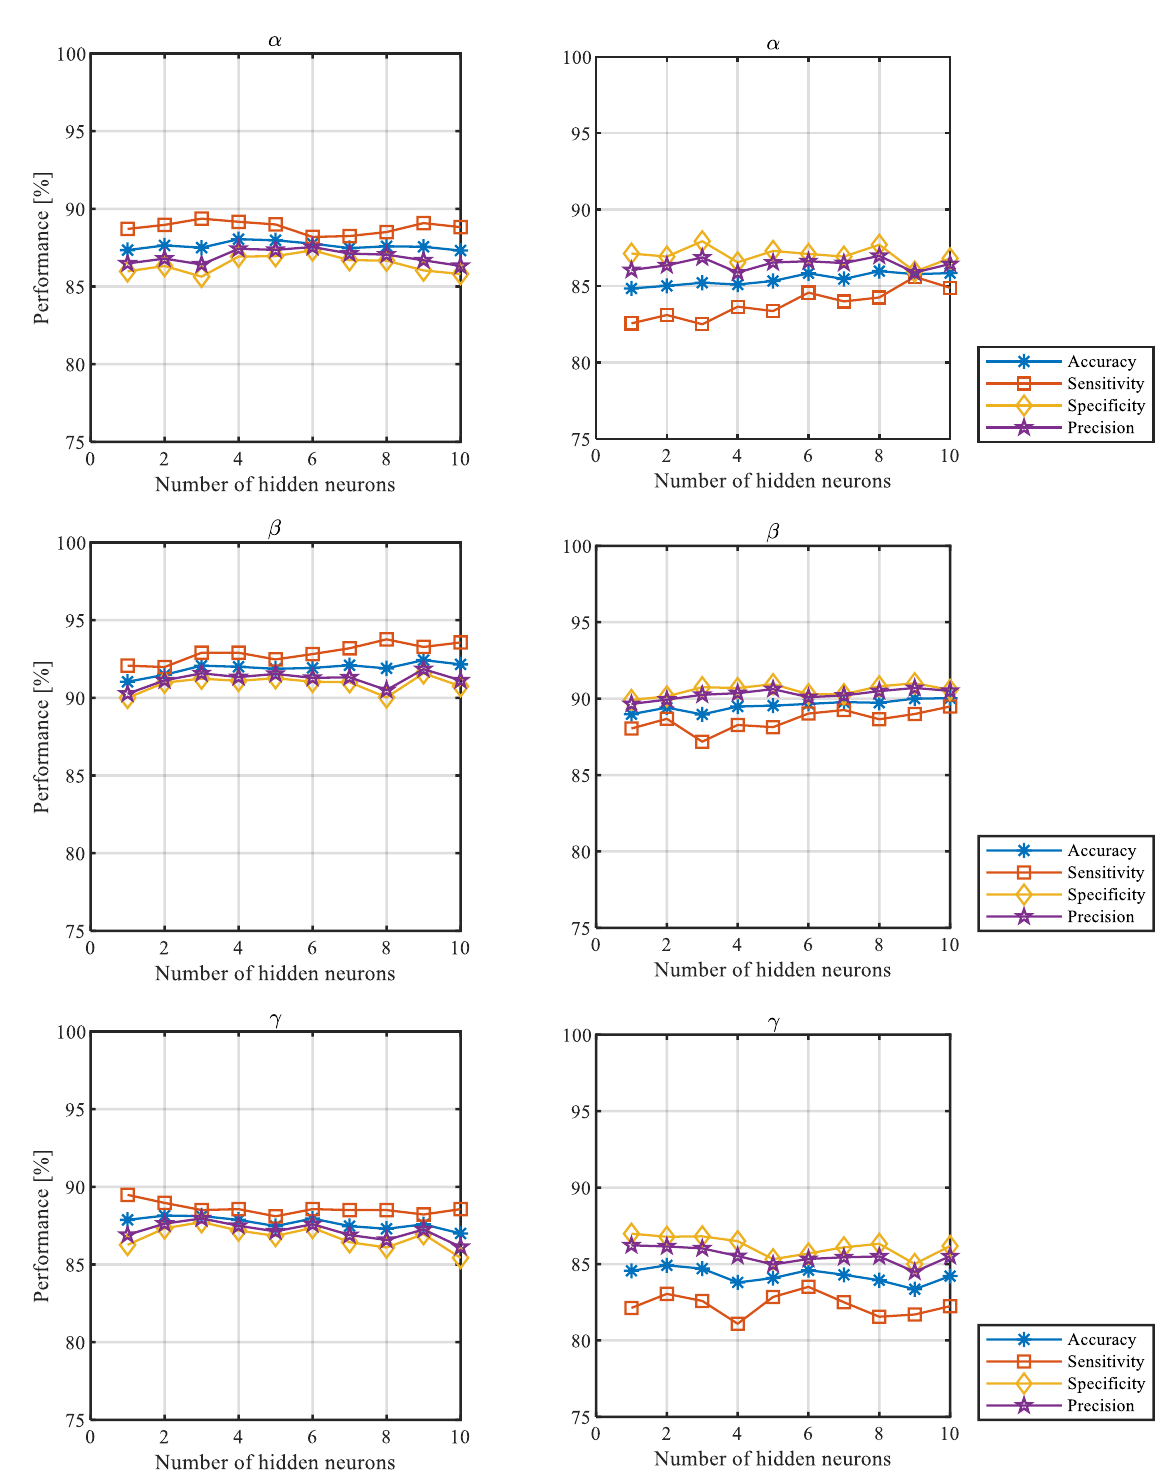
Figure A2. Network classification measures for selected single frequency bands ( α , β , γ ), where the training and testing feature set vectors were separated by different parts of the same sessions ( left , the first scenario) and different sessions ( right , the second scenario).